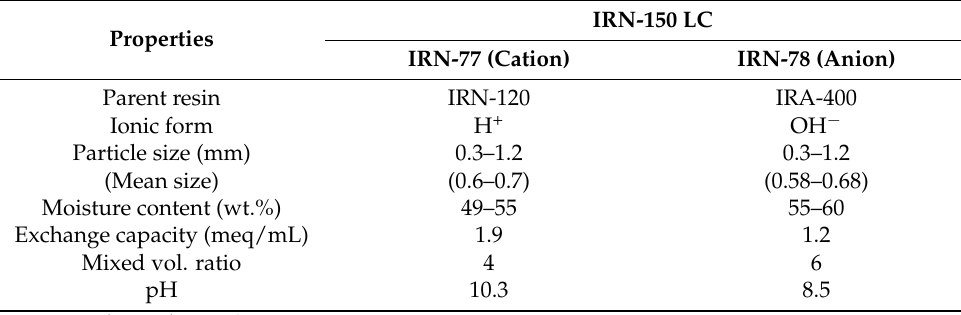
Table 6. Specifications of Amberlite IRN-150LC resin used in the tests